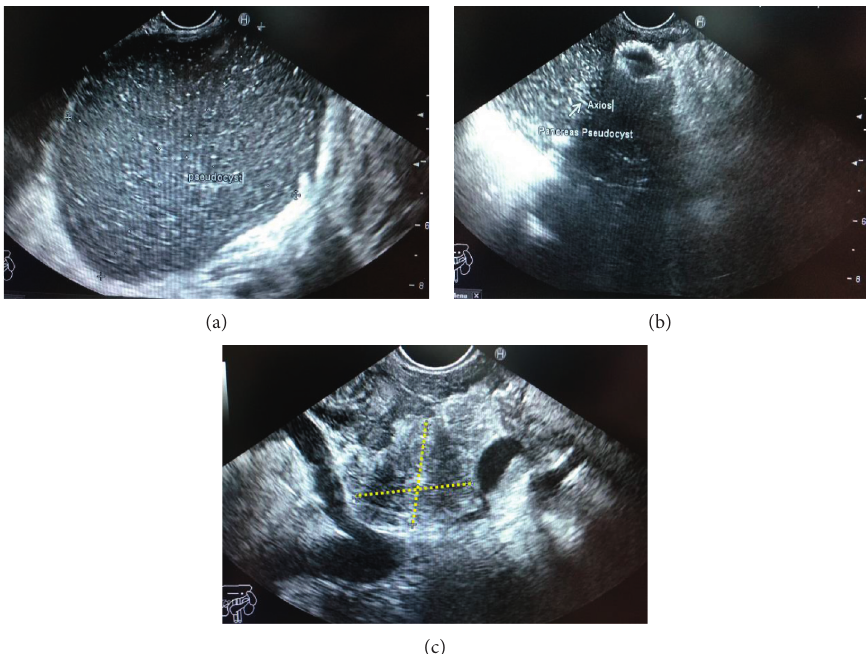
Figure 2: EUS image showing (a) a pancreatic pseudocyst before drainage and (b, c) the stent and pseudocyst after drainage (yellow dashed line).